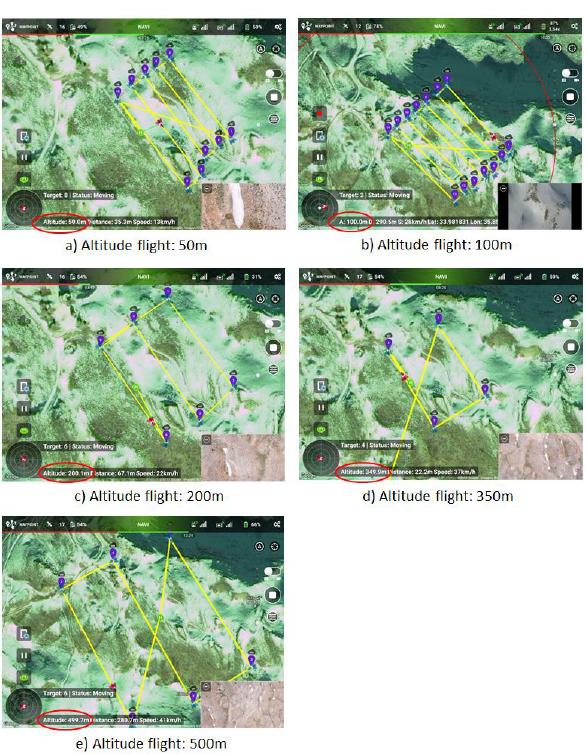
Figure A1: The five missions’ plans at different altitudes